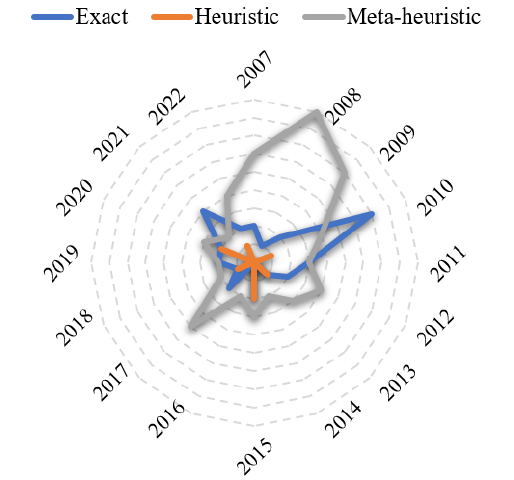
Fig. 10. Distribution of the papers on the solution methods of